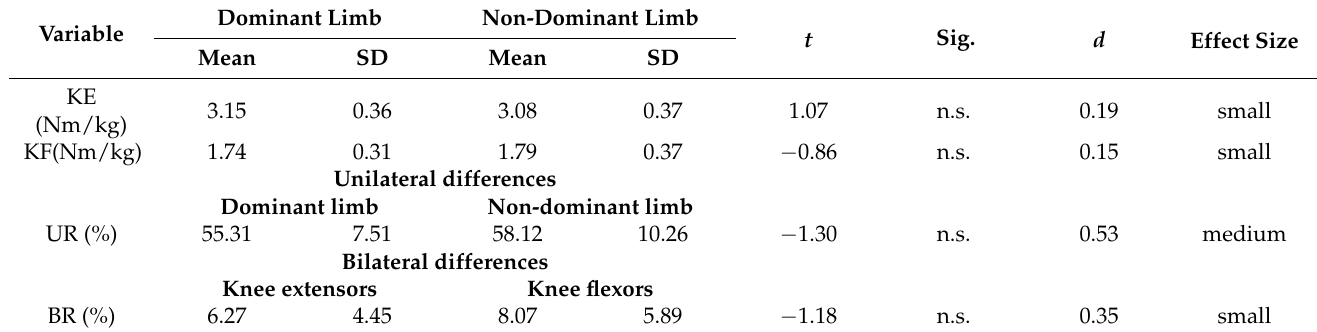
Table 3. Isokinetic strength performance and unilateral and bilateral strength ratios.